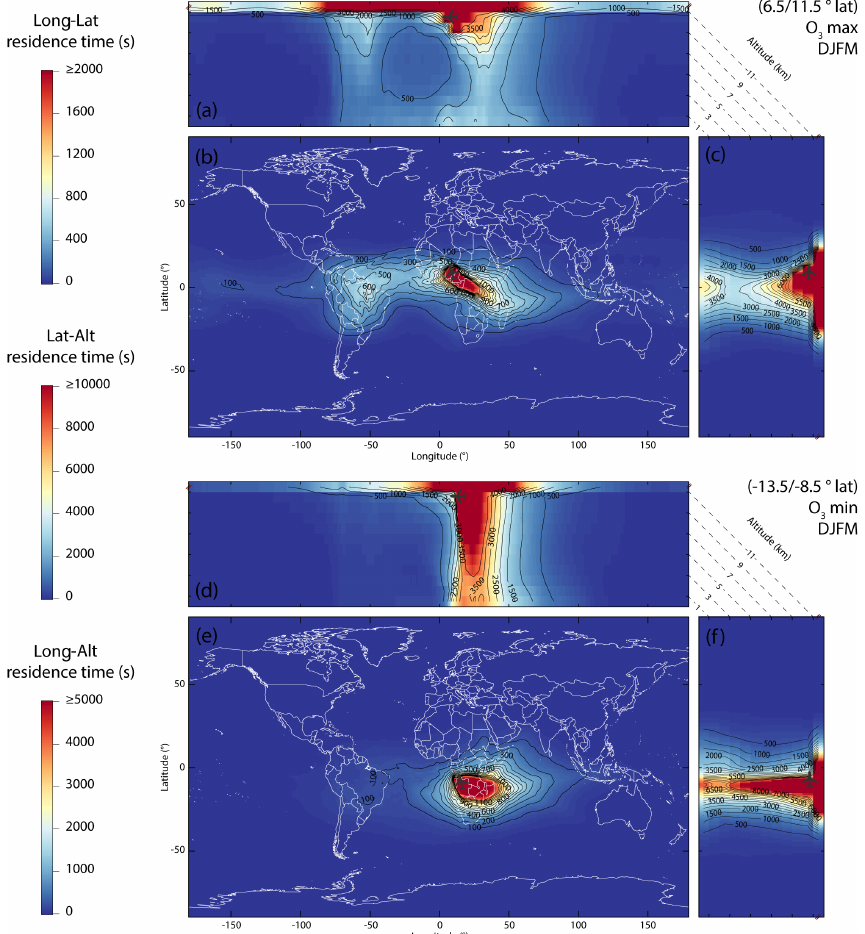
Figure 7. FLEXPART backward plume of air masses where IAGOS flights have recorded maxima (between 6.5 and 11.5 ◦ N: a, b, c ) and minima (between 13.5 and 8.5 ◦ S: d, e, f ) of ozone in DJFM. Plumes are represented in terms of the residence time of particles in each individual output box in seconds, summed on the 20d backward, on 5 ◦ lat of flight and on total column (latitude column for a, d , altitude column for b, e , and longitude column for c, f ), and averaged over all studied years. Note that the color scale is different for longitude–altitude profiles (a, d) , longitude–latitude maps (b, e) and latitude–altitude profiles (c, f)